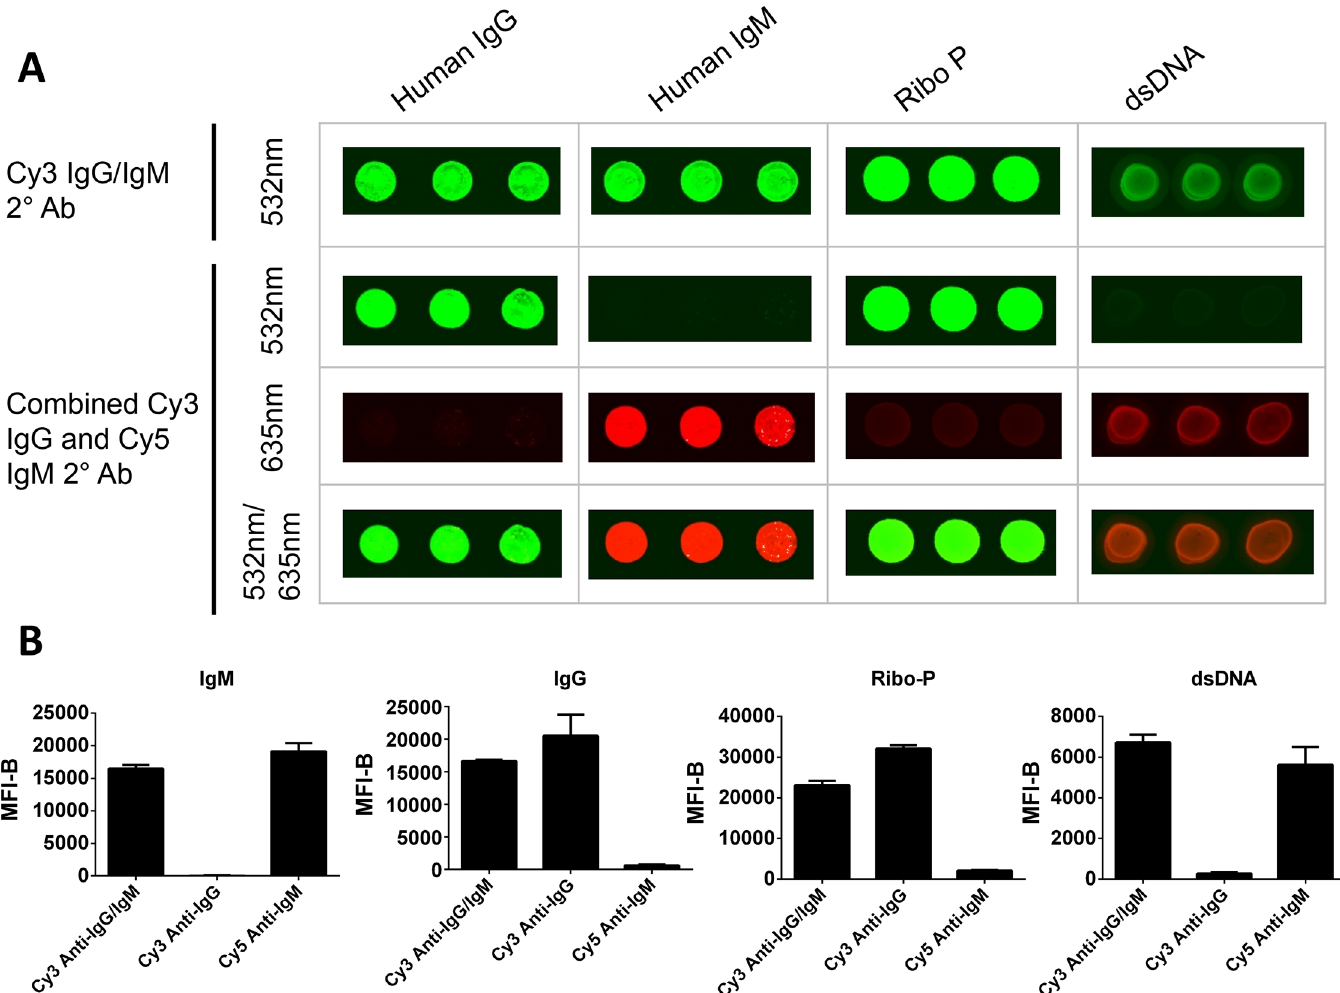
Fig 2. Generation of two-color antigen microarrays to detect IgM and IgG and comparison with single-color technique that detects IgG plus IgM antibody reactivities. (A) Human IgG, human IgM, ribosomal phosphoprotein P0, or dsDNA were spotted in triplicate onto nitrocellulose-coated slides. Slides were then probed with serum from a patient who was known to be reactive against ribosomal phosphoprotein P0 antigen. This was followed by probing with a Cy3-labeled secondary antibody that detected both IgM and IgG (top panel) or with two antibodies that specifically recognized IgM (Cy5-labeled) and IgG (Cy3-labeled) (bottom panels). Arrays were scanned and positive binding of the Cy3-labeled antibodies was detected at 532 nm while positive binding of the Cy5-labeled antibodies was detected at 635 nm as indicated. (B) Quantification of fluorescence detected from antigen microarrays at the two wavelengths. Graphs show mean ± SD median fluorescence intensity minus background (MFI-B) of the signal detected at the IgG, IgM, ribosomal phosphoprotein P0, and dsDNA spots at each wavelength. Each graph shows how reactivity detected by single secondary antibody (anti-IgG/IgM) can be separated into IgG and IgM reactivities using the antibody pair (anti-IgG and anti-IgM).